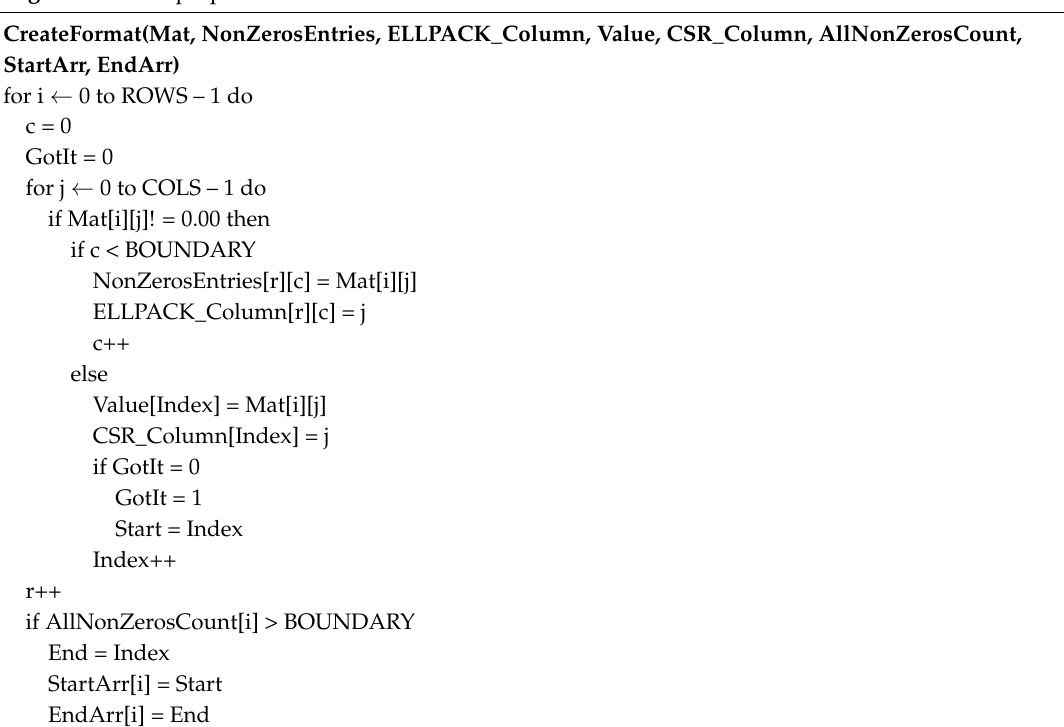
Algorithm 6 The proposed